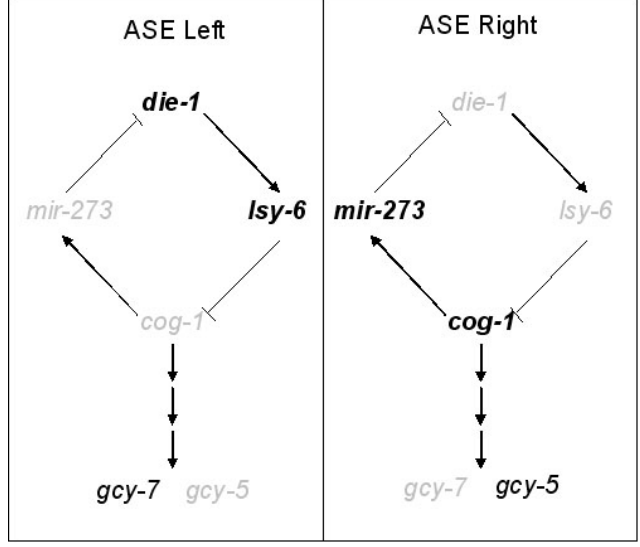
FIGURE 1 . ASE neuronal cell fate in C. elegans is controlled by a feedback loop. Summary of pathway generating gcy asymmetry in the ASEL and ASER. See text for details. Genes listed in black represent expressed genes. Genes in grey are not